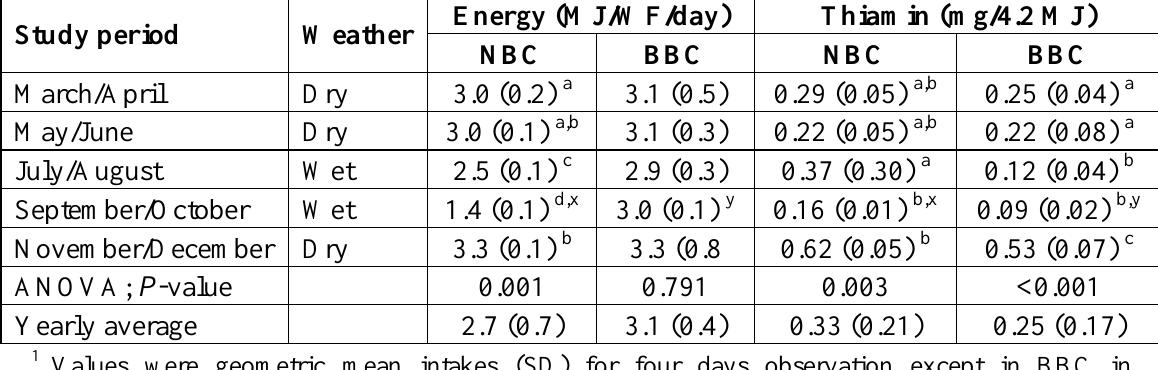
Table 2. Seasonal variations in energy (MJ/WF/day) and thiamin (mg/4.2 MJ) intakes in the study compounds NBC and BBC through one year 1,2,3